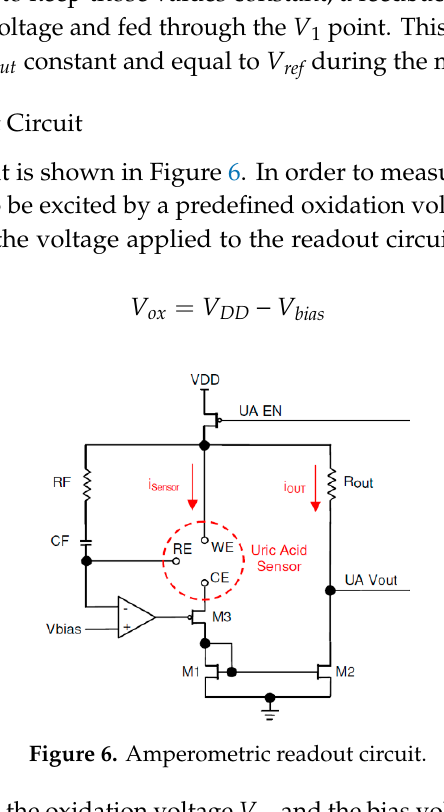
Figure 5. The constant-voltage, constant-current, floating bridge potentiometric readout circuit.